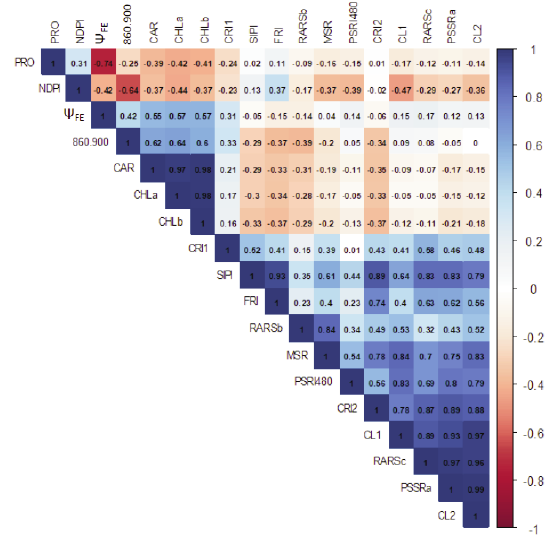
Fig. 6 ­ Correlations between variables with greater discrimina­ tion capacity for the different fruit conditions [Proline (PRO), Carotenoids (CAR), Chlorophylls (CHL)] measured by spectrophotometry in the laboratory, NDPI, 860­900, CRI1, SIPI, FRI, RARSb, MSR, PSRI480, CRI2, CL1, RARSc, PSSRa and CHL2, calculated based on reflectance measu­ rements in the field.